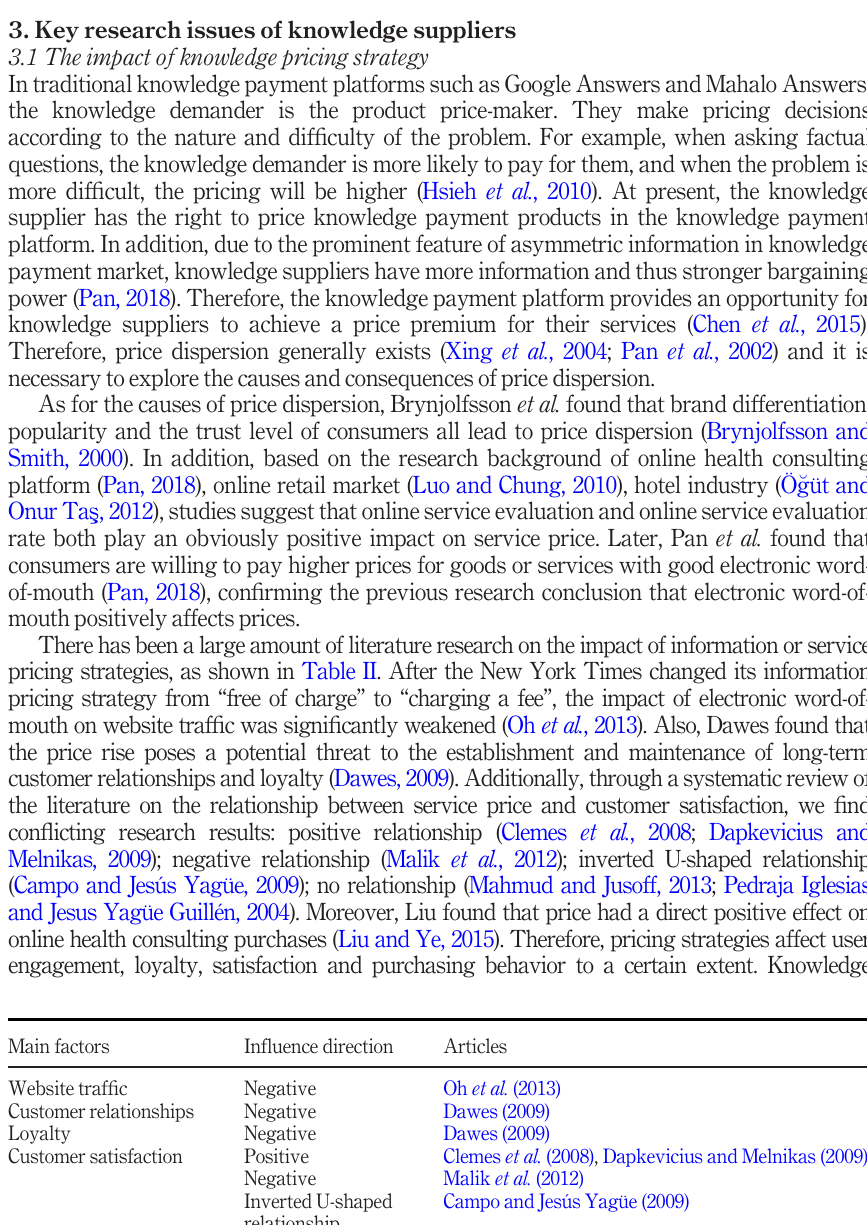
Table II. Effect of pricing